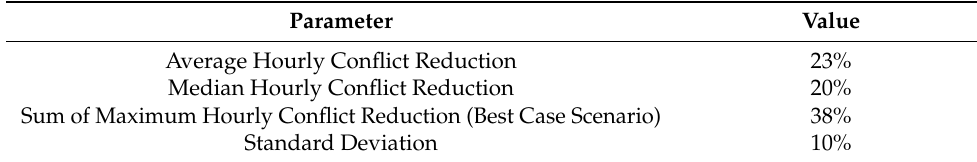
Table 2. Projected safety benefits on 128th Street and 72nd Avenue. Parameter